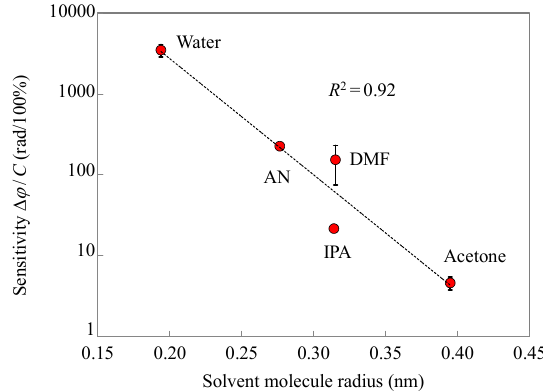
Fig. 6 Sensitivity of MZI waveguide sensor to vapor of different organic solvents as a function of solvent molecule radius. PMMA + DMABI-Ph6 cladding thickness is 1.2 μ